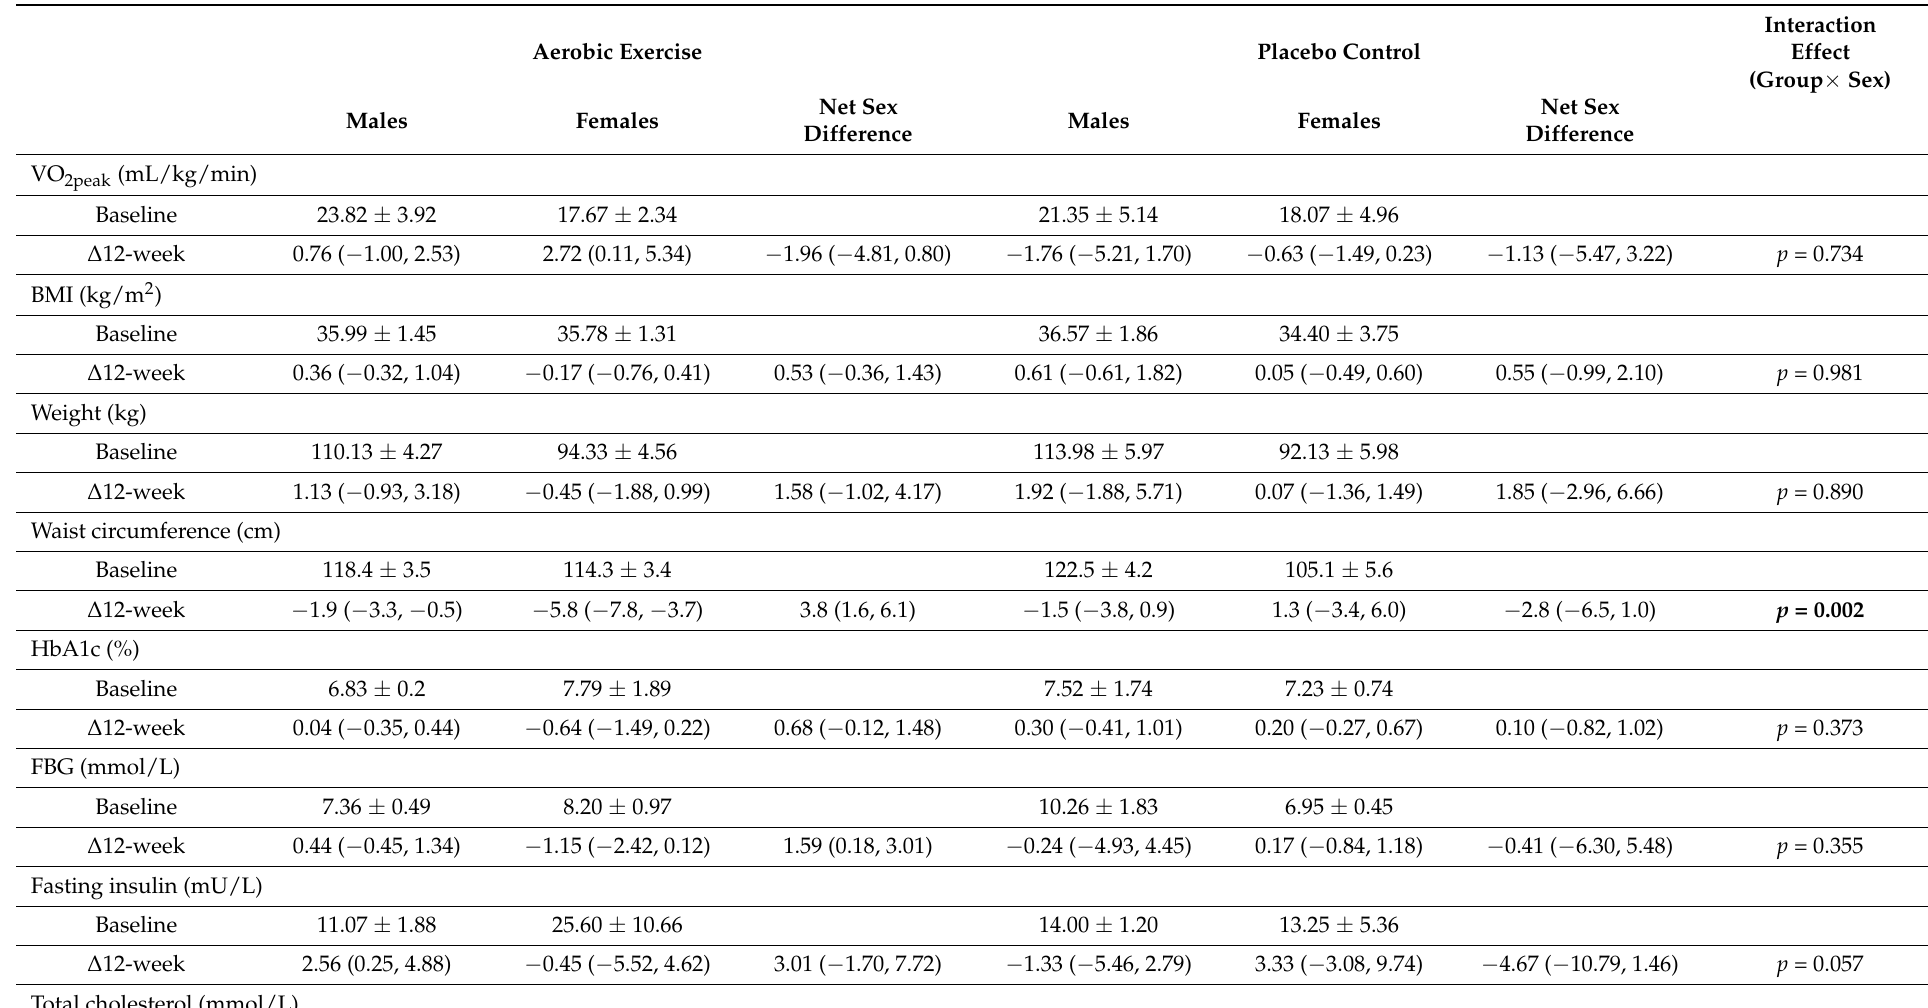
Table 4. Mean baseline cardiometabolic health indicators, within-group changes relative to baseline, and net sex differences per intervention. Aerobic Exercise Placebo Control